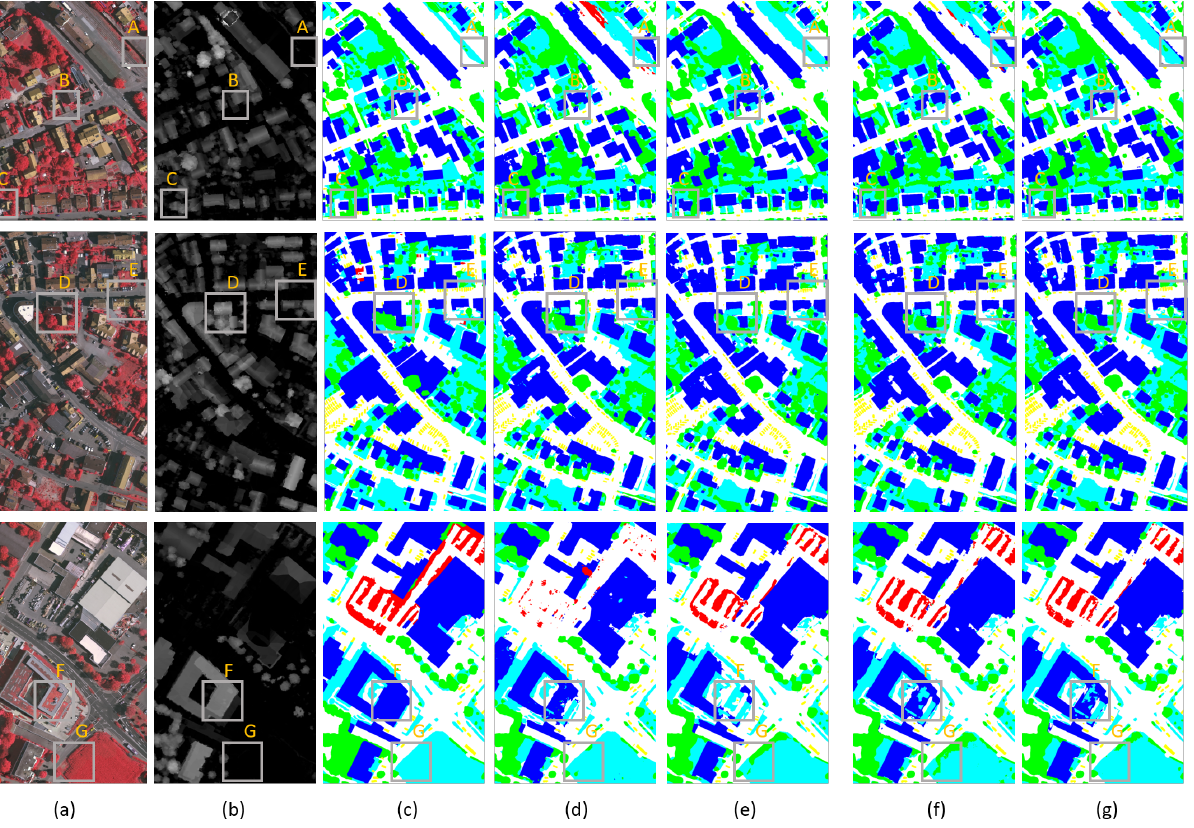
Figure 5. Visual comparison of different methods: ( a ) Color images(IRRG); ( b ) Depth images; ( c ) Ground truth; ( d ) Upernet; ( e ) Swin; ( f ) Segformer-B4; ( g ) EDFT-B4. Three rows of images represent the area 10, 27, and 33 from the Vaihingen dataset. The inference map is labeled with impervious surface (white), building (blue), low vegetation (cyan), tree (green), car (yellow), and clutter